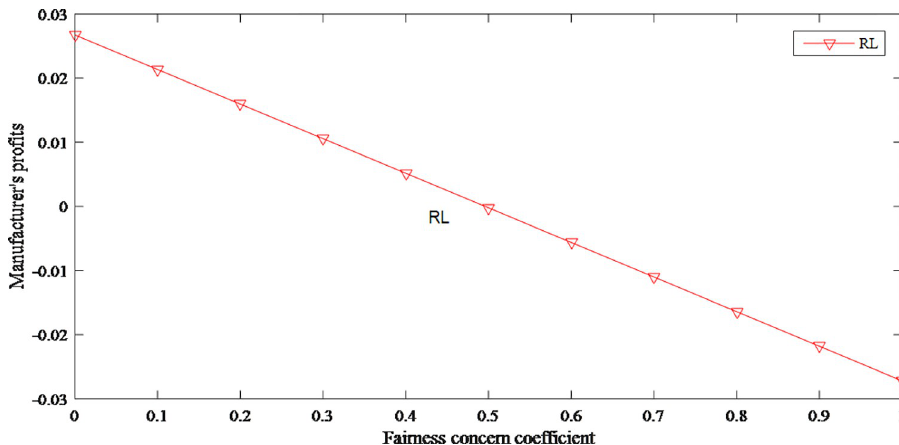
Fig 13. The impact of fairness concerns on manufacturer’s profits.